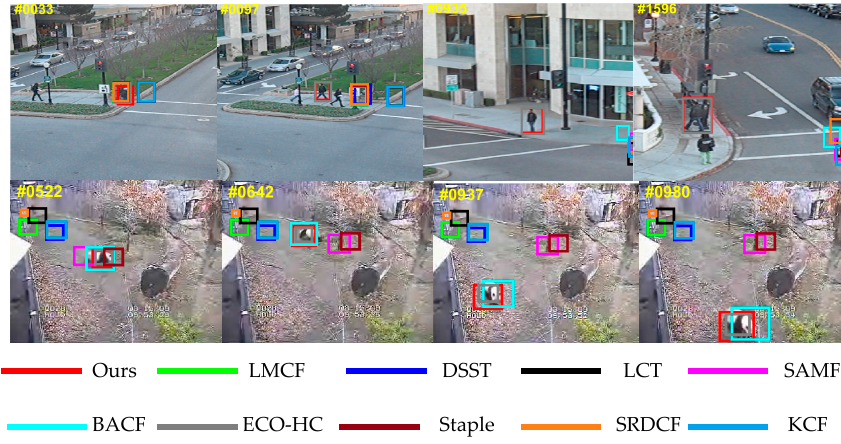
Figure 7. Qualitative experimental results from four representative videos. Ten different colors represent representative ten trackers, respectively.